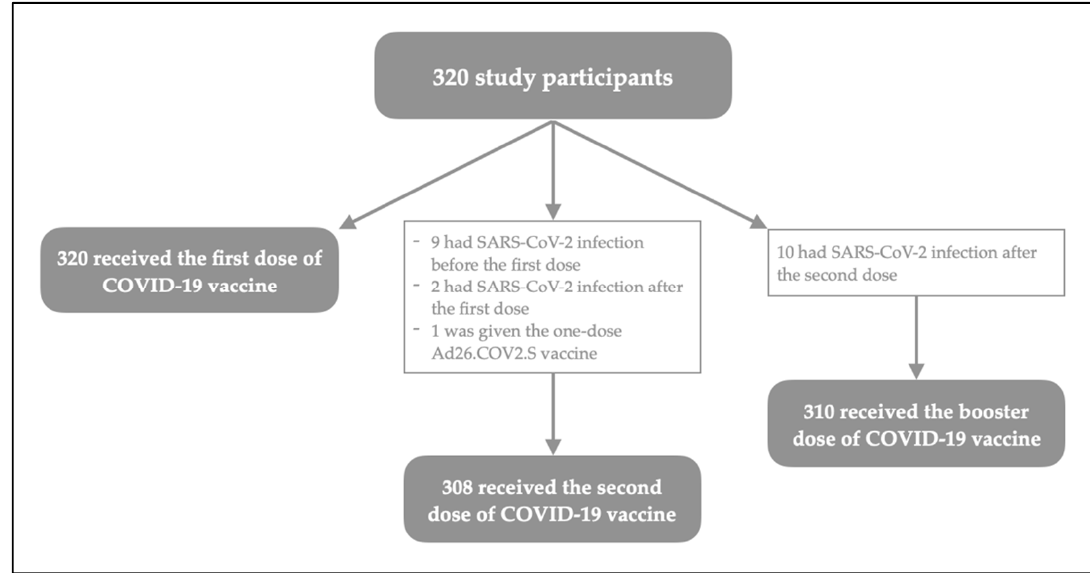
Figure 1. History of COVID-19 vaccination among study participants.